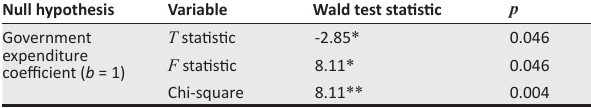
TABLE 9: Coefficient restriction Wald test results.